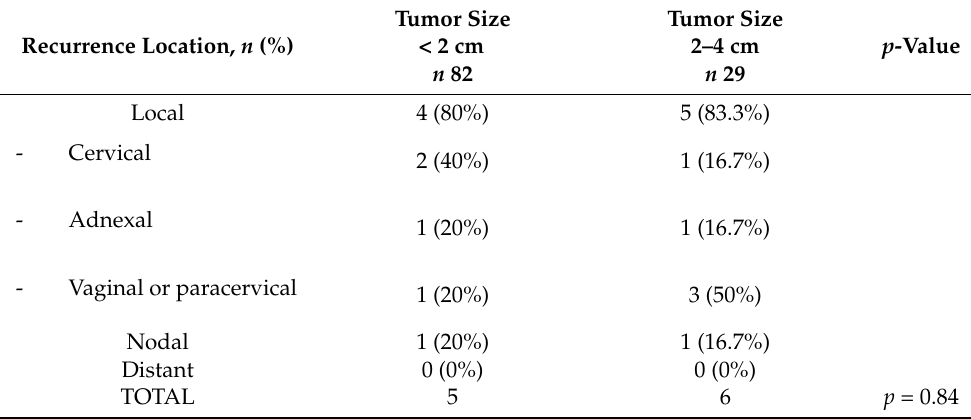
Table 2. Recurrence locations of both populations.